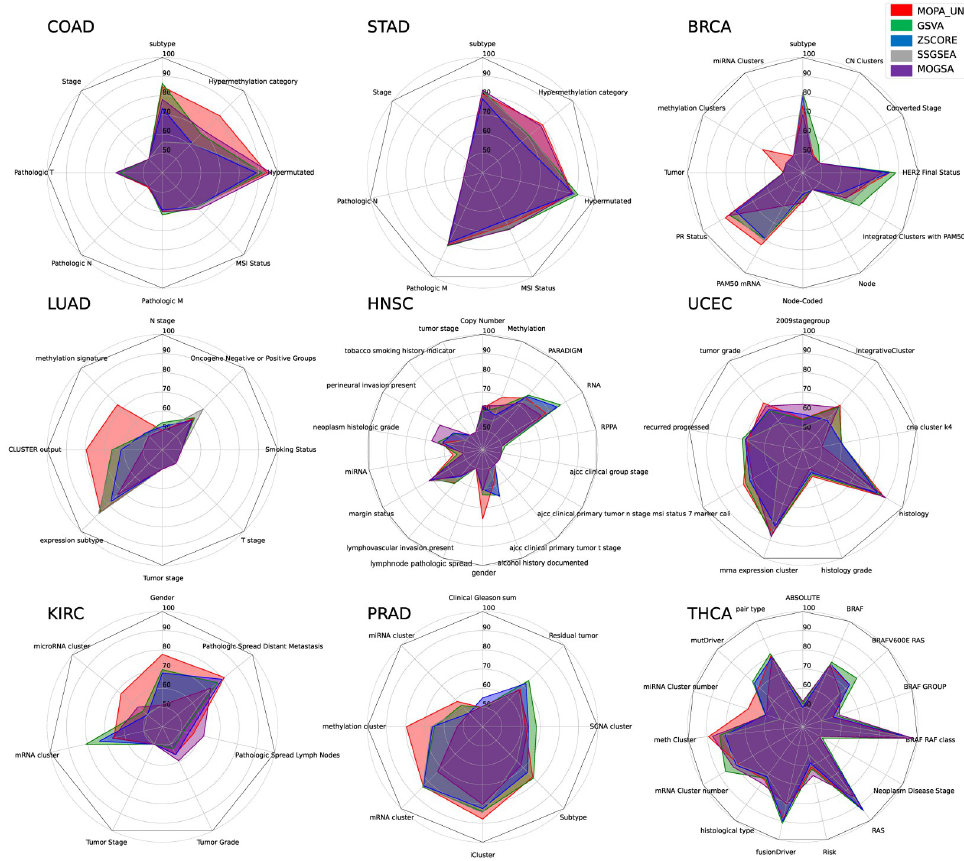
Fig 5. The classification performance comparison of five different pathway scoring methods. The F1 score of 93 different clinical features in nine cancer types was measured for each pathway scoring method.